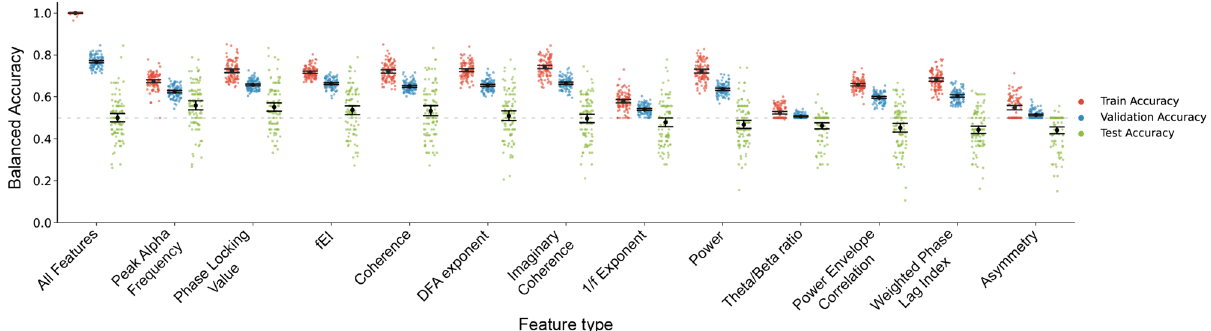
Figure 6. Performance of each feature type with logistic regression with L1 regularization. The logistic regression with all features are shown on the left, followed by the performances of each individual feature type, sorted according to average balanced test accuracy (green points). The dashed line indicates chance-level performance. Most of the feature types displayed significant training (red points) and validation (blue points) accuracies, which did not survive when tested on completely unseen data (cf. Fig. 7). Mean with 95% confidence intervals are